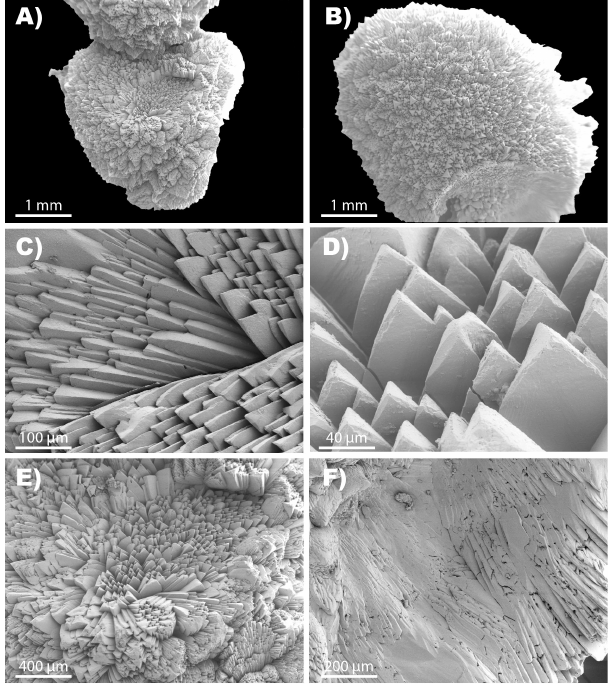
Fig. 3. SEM photomicrographs of coarse crystalline cryogenic cave carbonates (CCC coarse ) aggregates found in Leclanch´e Cave. Note the ubiquitous presence of euhedral (rhombohedral) crystal termi- nations except for local dents ( F ) which represent the interface to an adjacent (now detached) spheroid.